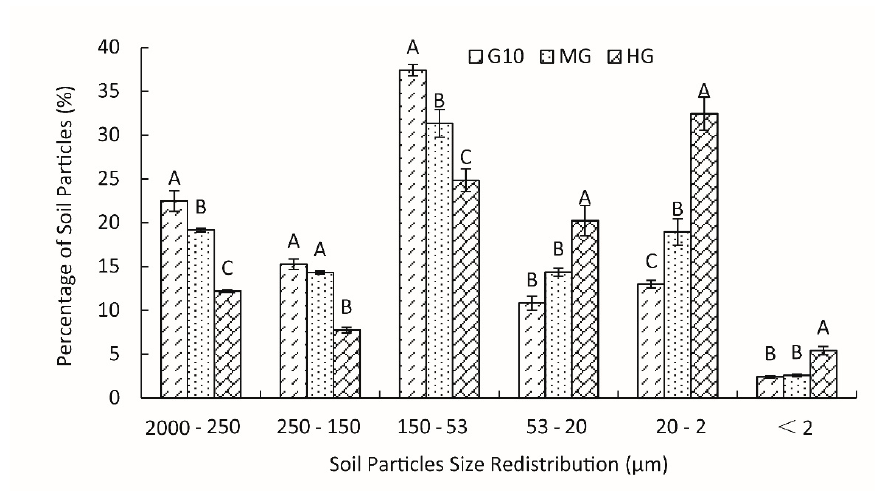
Figure 1. The redistribution of soil particles under different grazing intensities. Different uppercase letters indicate significant differences among the different grazing intensities at p ≤ 0.05. G10 represents 10-year enclosure grassland without grazing; MG represents moderate grazing grassland with 10 goats ha − 1 ; HG represents heavy grazing grassland with 14 goats ha − 1 . When 0–60-cm soil depth was divided into four different layers (0–10, 10–20, 20–40 and 40–60